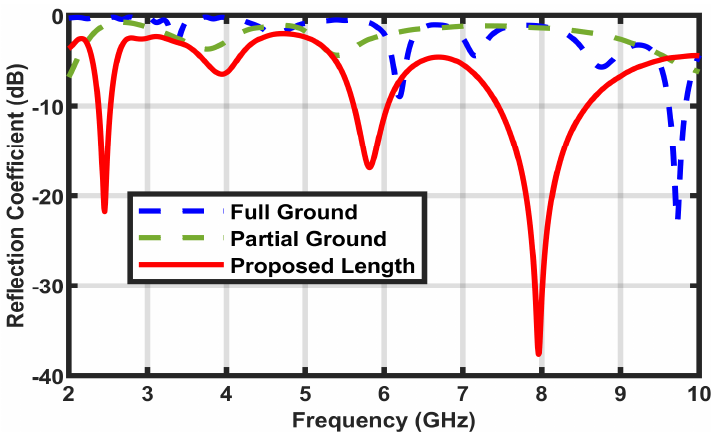
Figure 4. Effect of varying the length of the ground